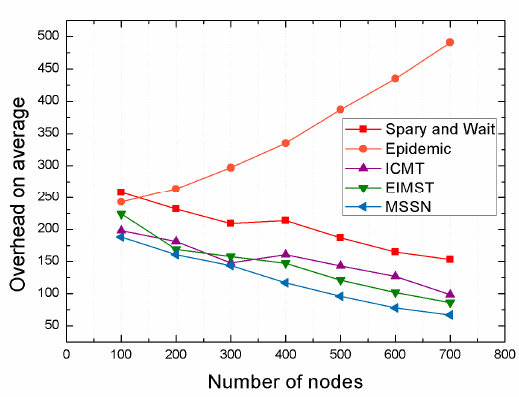
Figure 10. Overhead on average with different number of nodes.